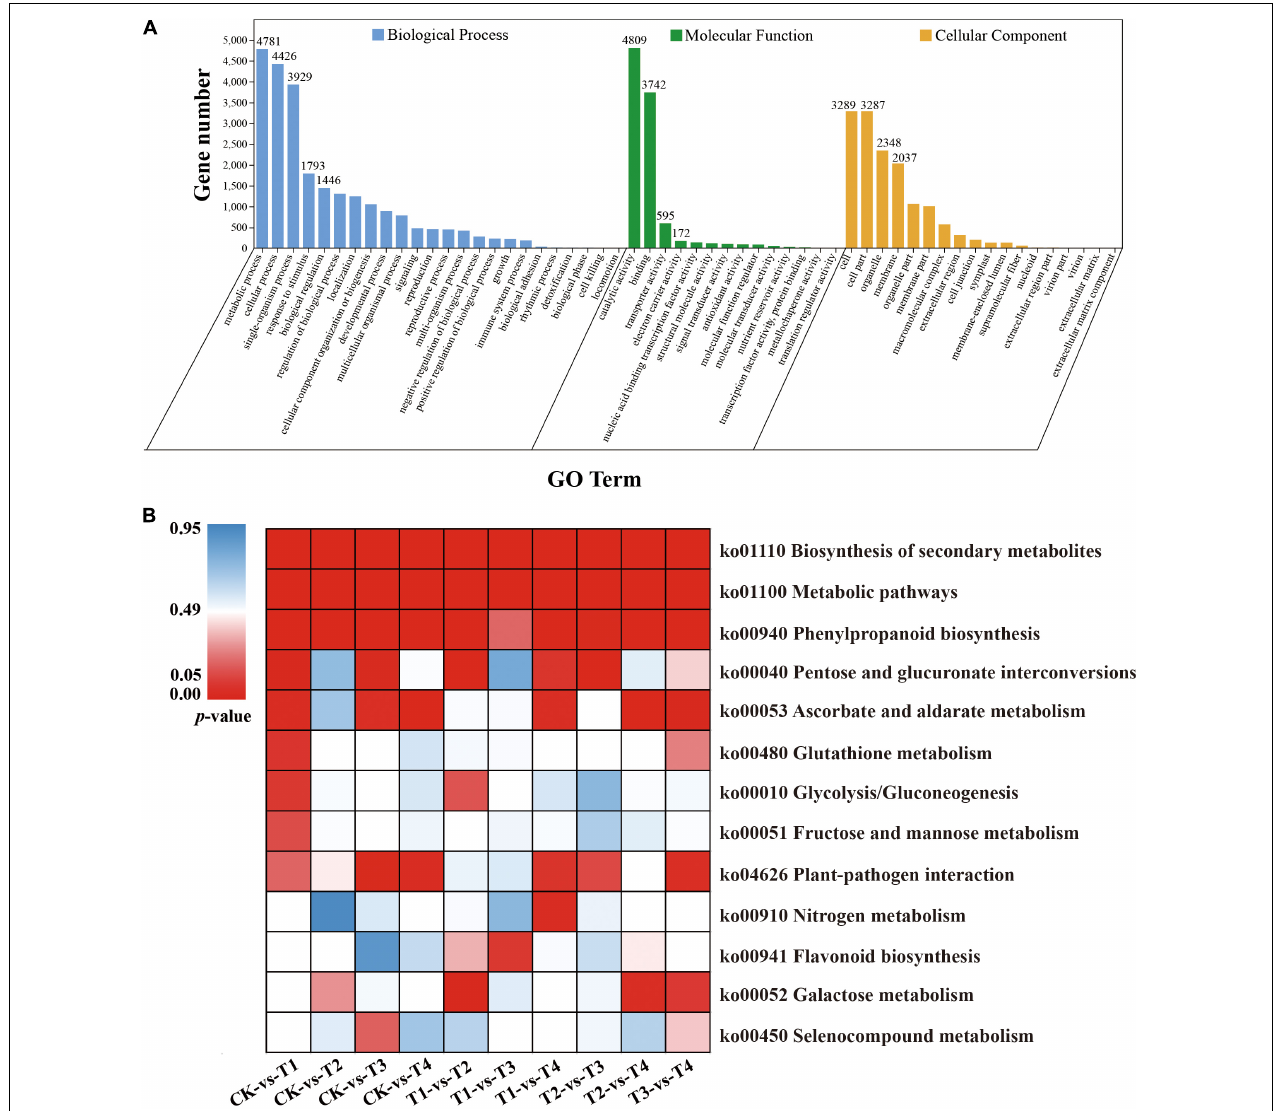
FIGURE 3 | GO and KEGG enrichment analysis of all DEGs. (A) GO enrichment results of all DEGs (B) Enrichment of the top 13 KEGG pathways of all DEGs according to the p -value. The red represents significant